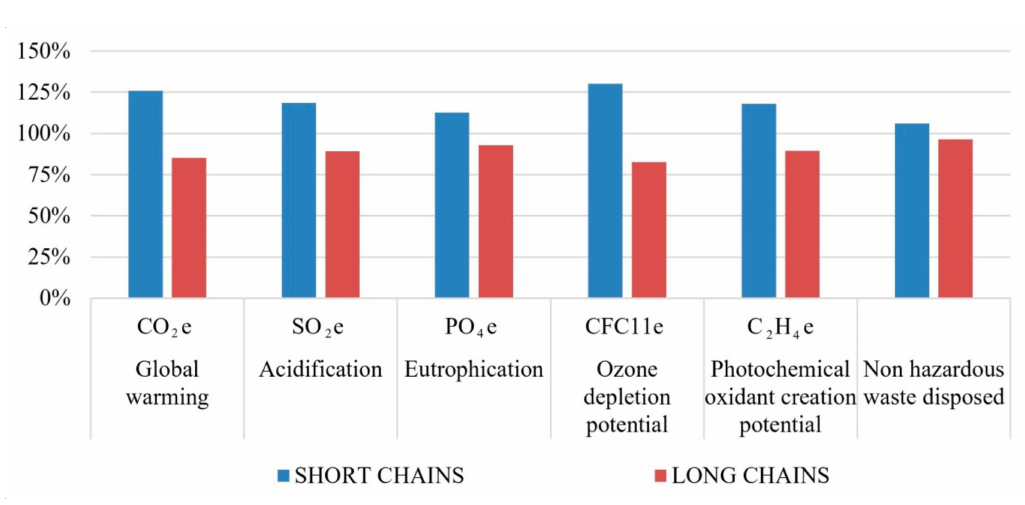
Figure 4. Average eco-e ffi ciency indicators for short and long food supply chains related to weighted mean value (mean = 100%). Source: own